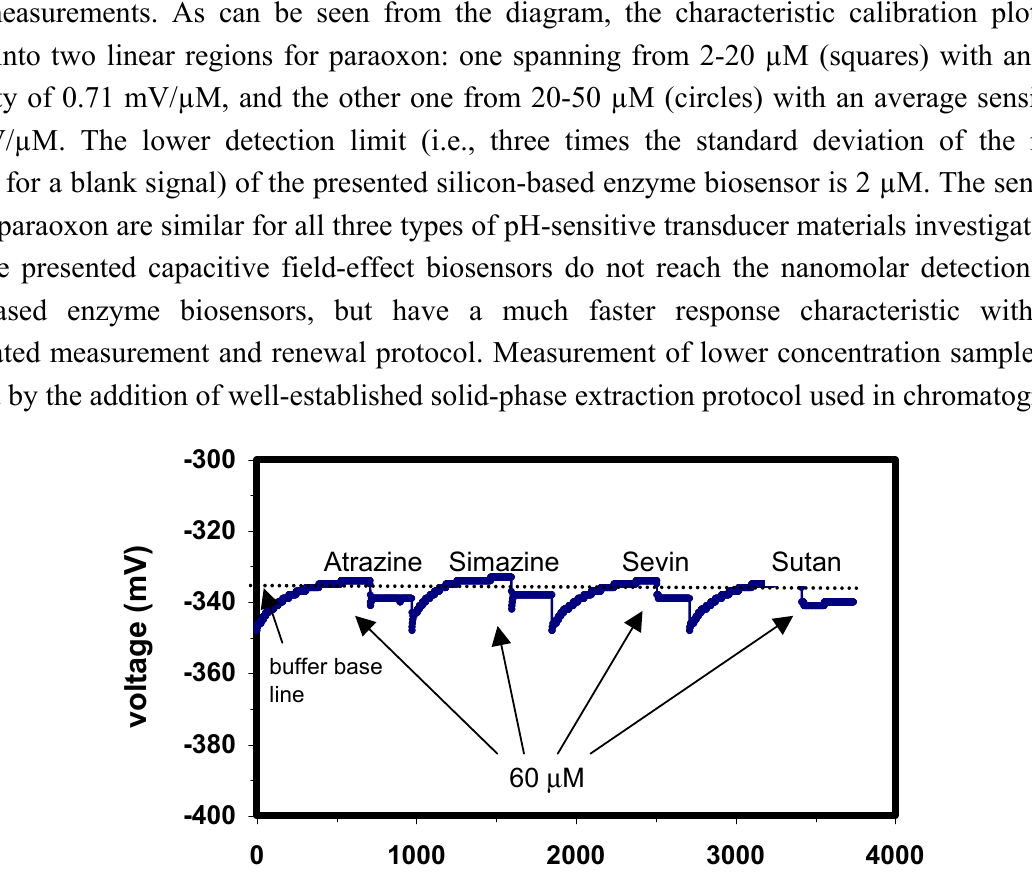
Figure 7. Selectivity measurement of the enzyme biosensor with Ta ConCap plot is recorded for 60 µM atrazine, simazine, sevin and sutan.